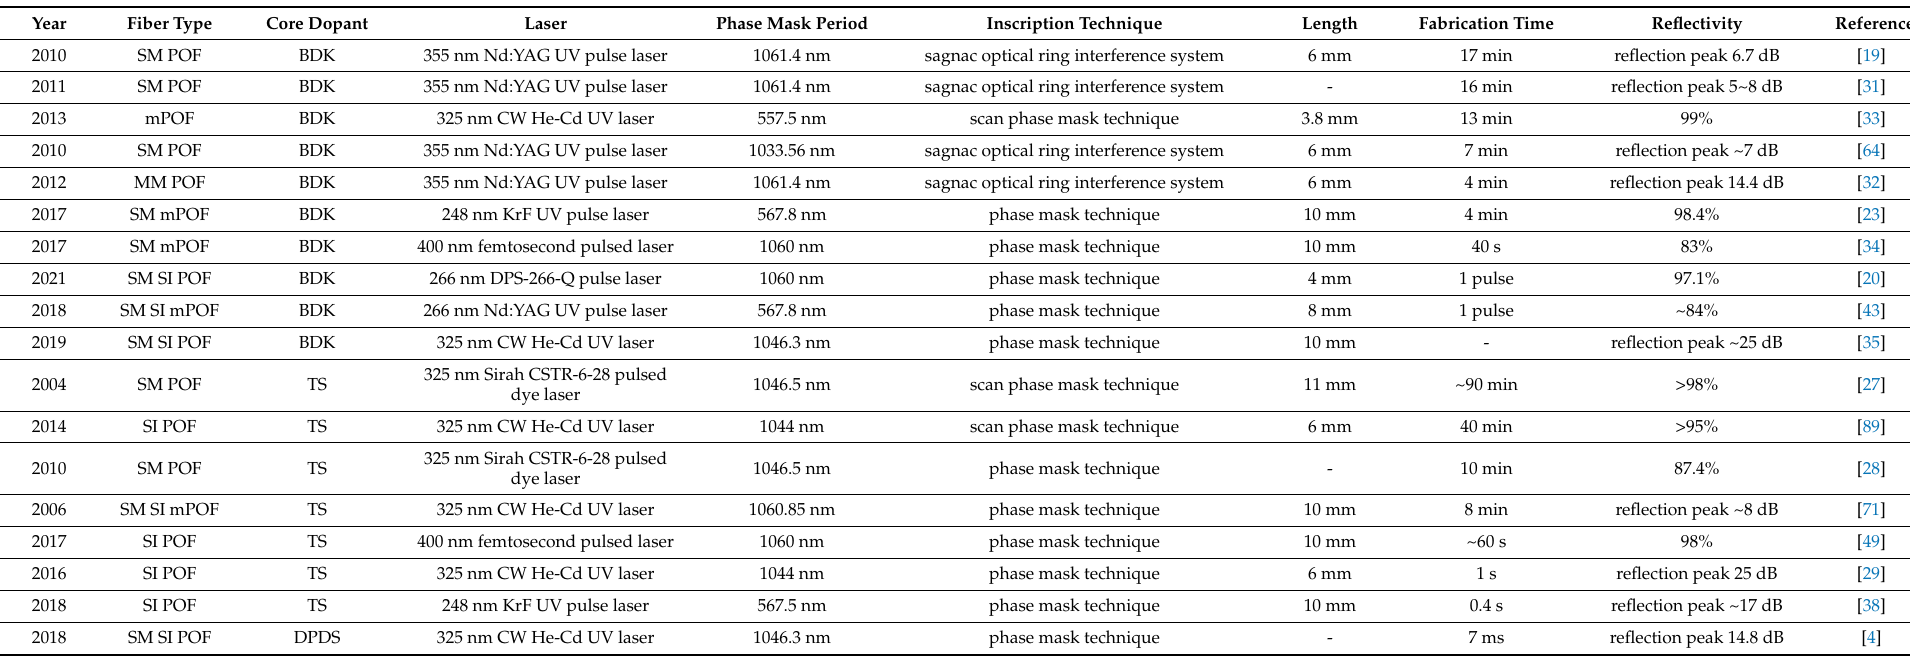
Table 2. The detailed FBG fabrication parameters in doped PMMA